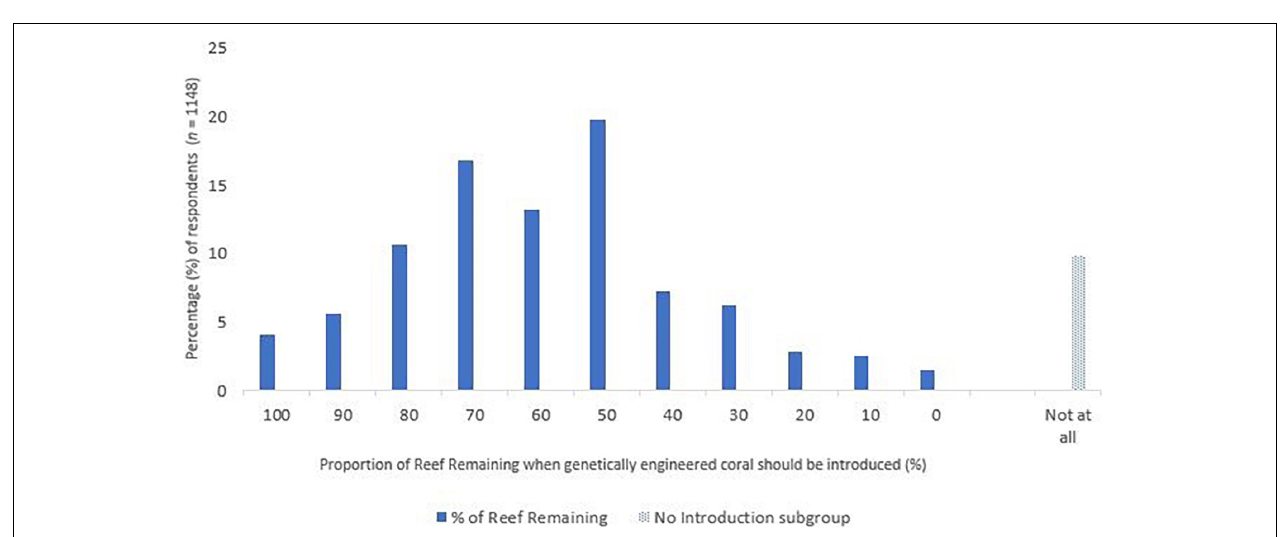
FIGURE 2 | Distribution of participant responses ( N = 1148) when asked to determine when it would be most appropriate to introduce genetically modified coral into the Great Barrier Reef based on the percentage of remaining reef (i.e., level of reef degradation). The “No Introduction” subgroup ( n = 113) represents those who were not comfortable with genetically modified coral being introduced at